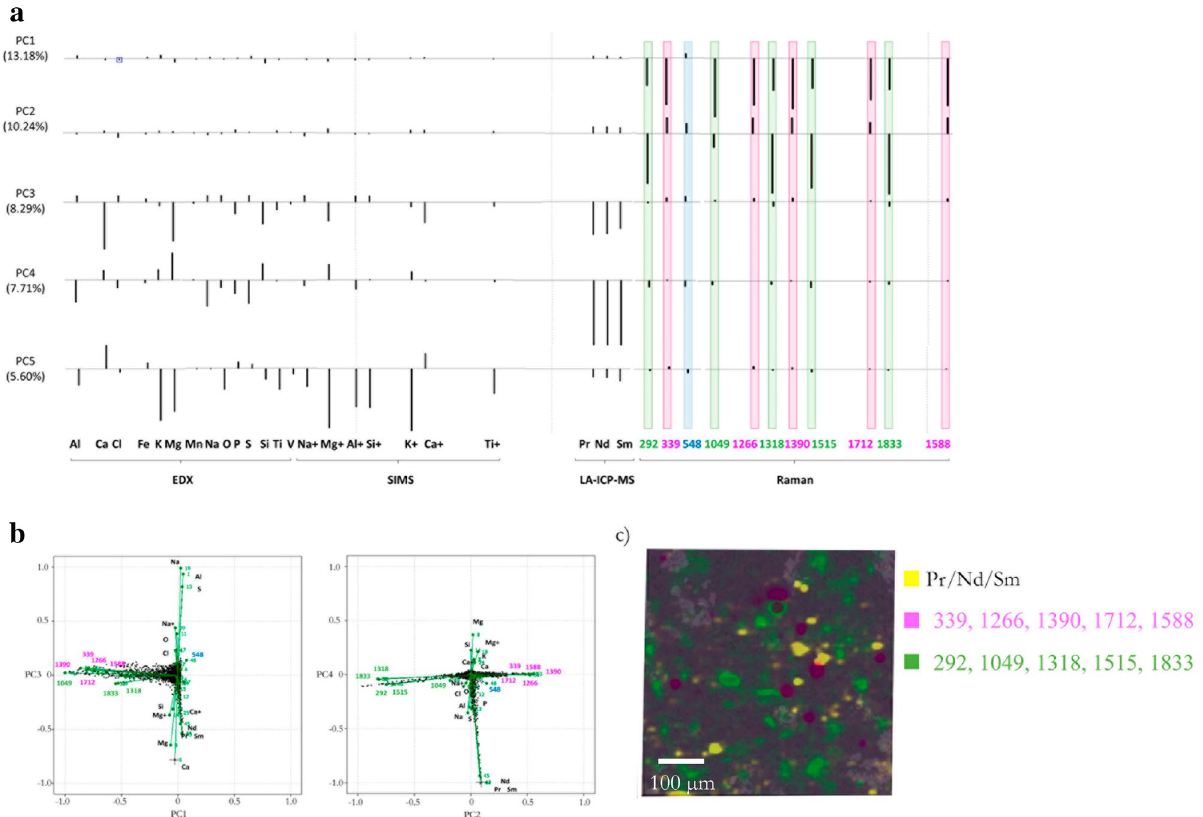
Figure 7. ( a ) Loadings of PC1 to PC5 obtained in NU-3 sample PCA model. ( b ) Scores-loadings biplot of PC1 vs PC3 and PC2 vs PC4. ( c ) SEM image superposed with the spatial distribution of clusters corresponding to REE elements (yellow) and characteristic Raman bands (pink and